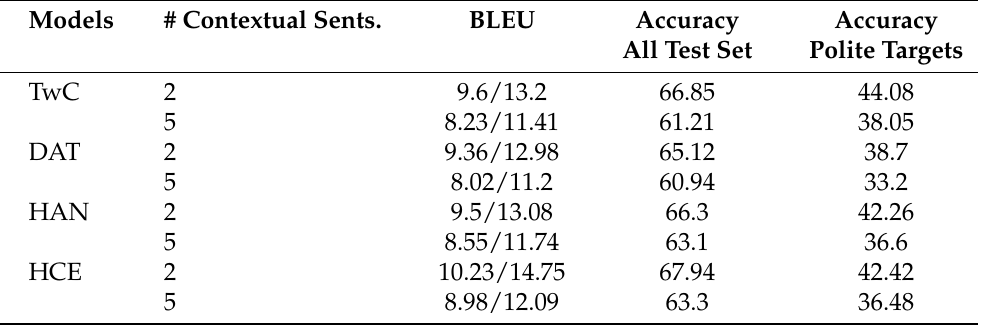
Table 5. English-Korean BLEU scores (normal/tokenized) and accuracy (%) by the number of contex- tual sentences on all of the context-aware NMT models